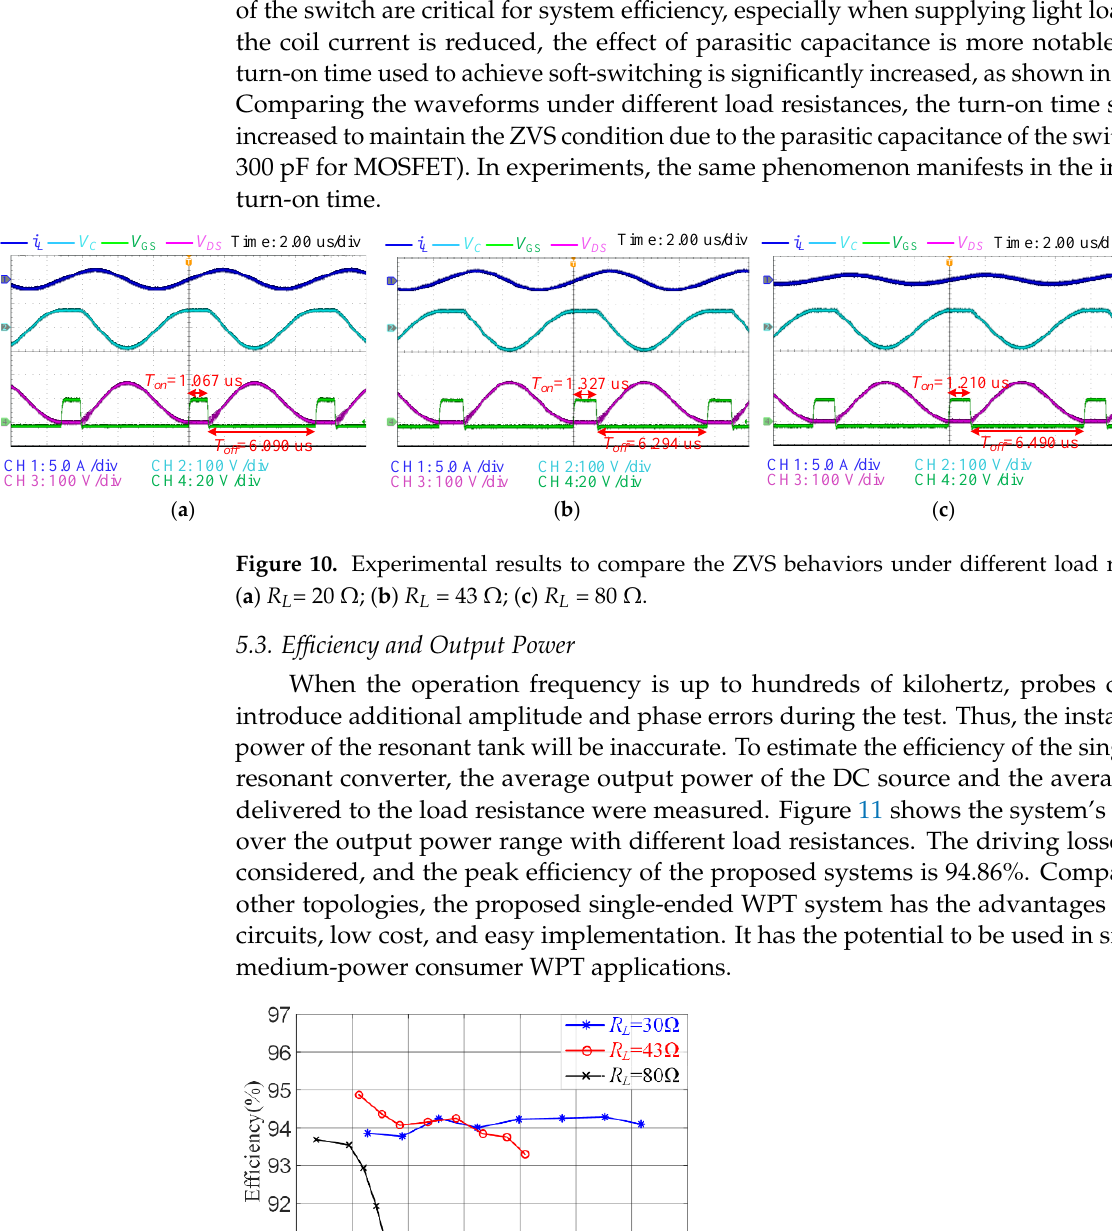
Figure 9. Comparison of calculated, simulated, and experimental critical ZVS conditions under dif- ferent load resistances. The critical ZVS conditions of the single-ended resonant converters can be calculated using (18) – (26). Since the switching frequency is up to hundreds of kilohertz, the param- eters of the switch are critical for system efficiency, especially when supplying light loads. Since the coil current is reduced, the effect of parasitic capacitance is more notable, and the turn-on time used to achieve soft-switching is significantly increased, as shown in Fig- ure 10. Comparing the waveforms under different load resistances, the turn-on time should be increased to maintain the ZVS condition due to the parasitic capacitance of the switch (about 300 pF for MOSFET). In experiments, the same phenomenon manifests in the increase in turn-on time.